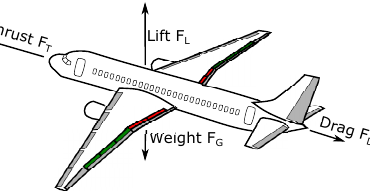
Figure 1. Forces acting on an aircraft in the flight-path-oriented coordinate system. Thrust F T and drag F D form the x